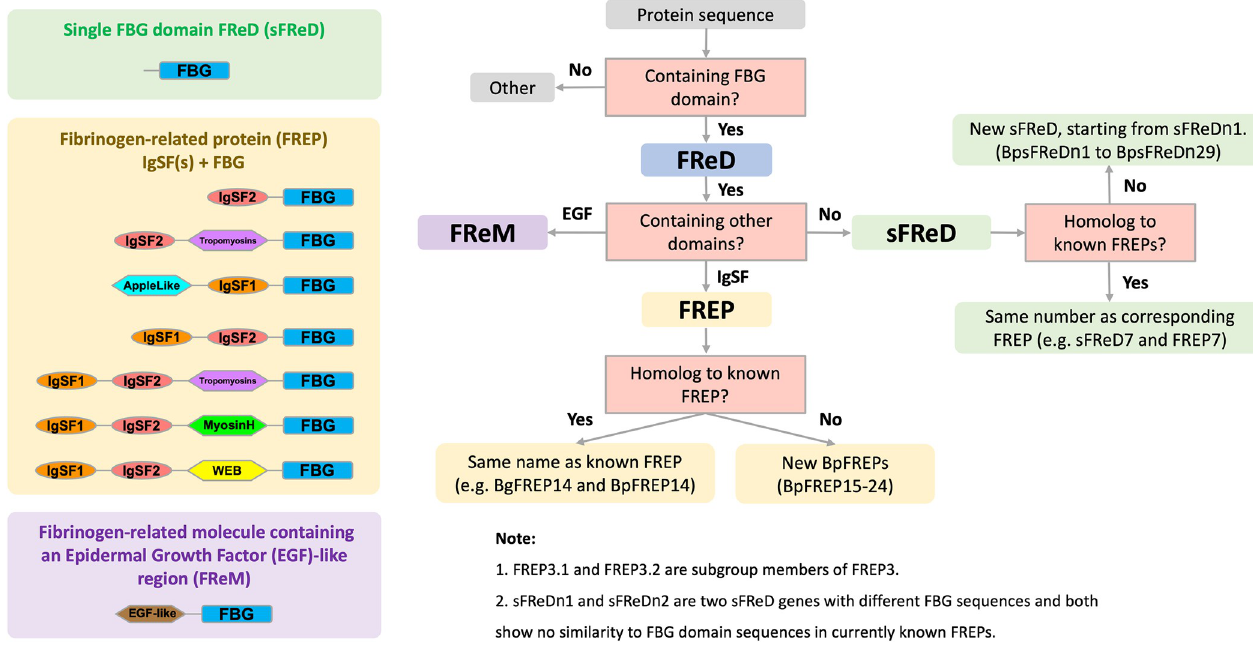
Fig 2. Nomenclature for B . pfeifferi Fibrinogen-Related Domain-containing proteins (FReDs). The FReD family is an inclusive, more general group containing the following subgroups: 1) sFReDs, or single FBG FReDs (containing FBG domain only); 2) FREPs, with 1 or 2 IgSF(s) joined via an interceding region (ICR) to a single FBG domain; and 3) FReMs (consisting of an epidermal growth factor domain (EGF) and a FBG domain. FREPs are therefore a sub- category within the FReD family. The domain structures for three main classes of known FReDs (green for sFReDs, yellow for FREPs and purple for FReMs) are summarized on the left, edited from Lu et. al (2020). The nomenclature logic process was displayed as a decision tree on the right. Naming convention tests (yes, no, or other) were made based on the test questions in pink boxes with gray frames. Final names were assigned into 5 classes: FReM, FREP1-14, FREP15- 24 (novel FREPs), sFReD1-14, and sFReDn1-n29 (new sFReDs).